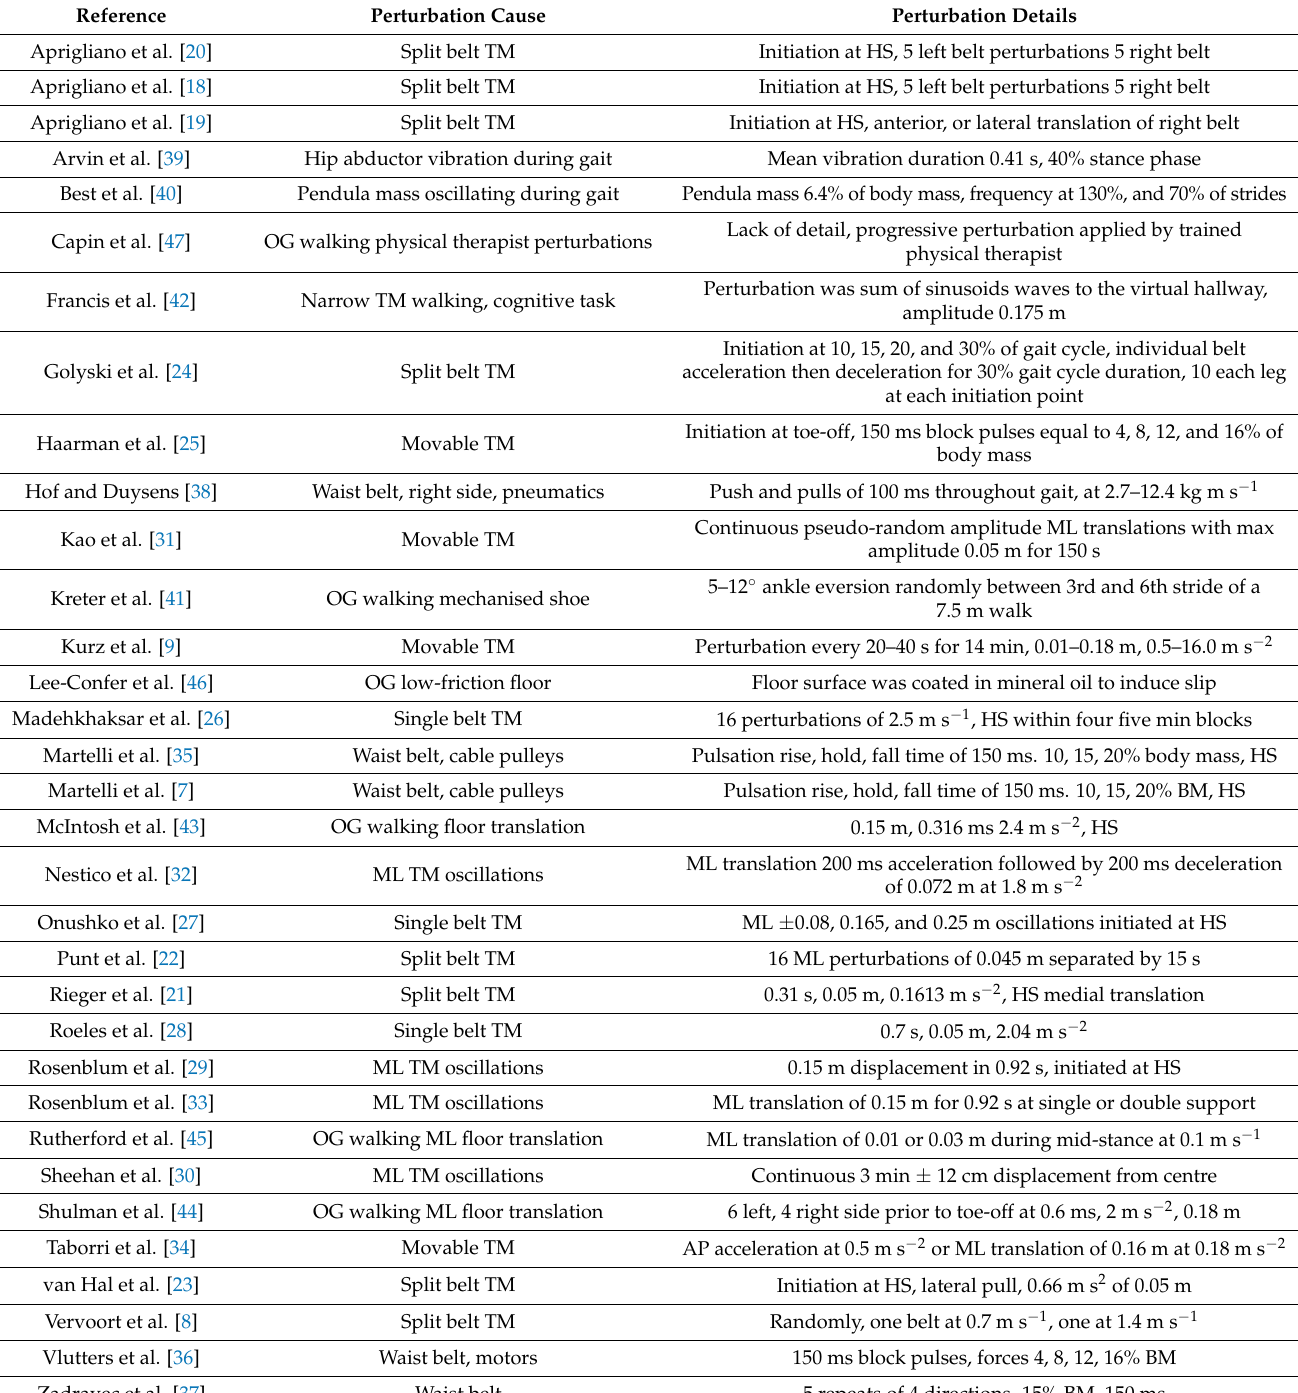
Table 2. Details of perturbation